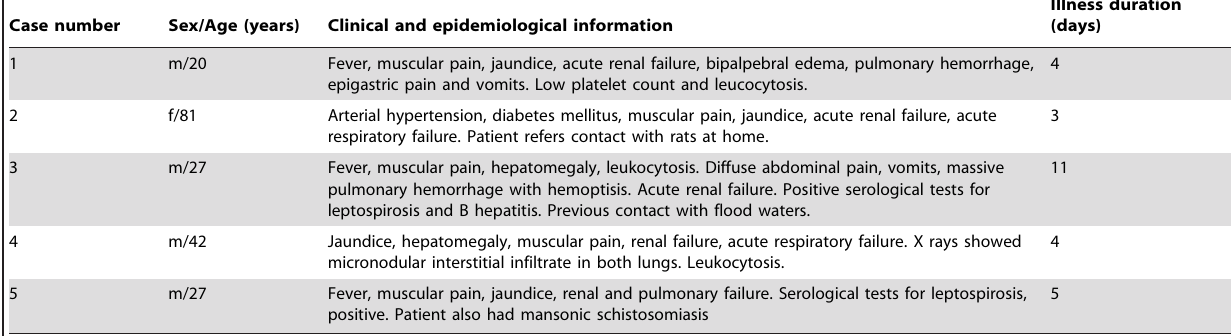
Table 1. Clinical data of leptospirosis